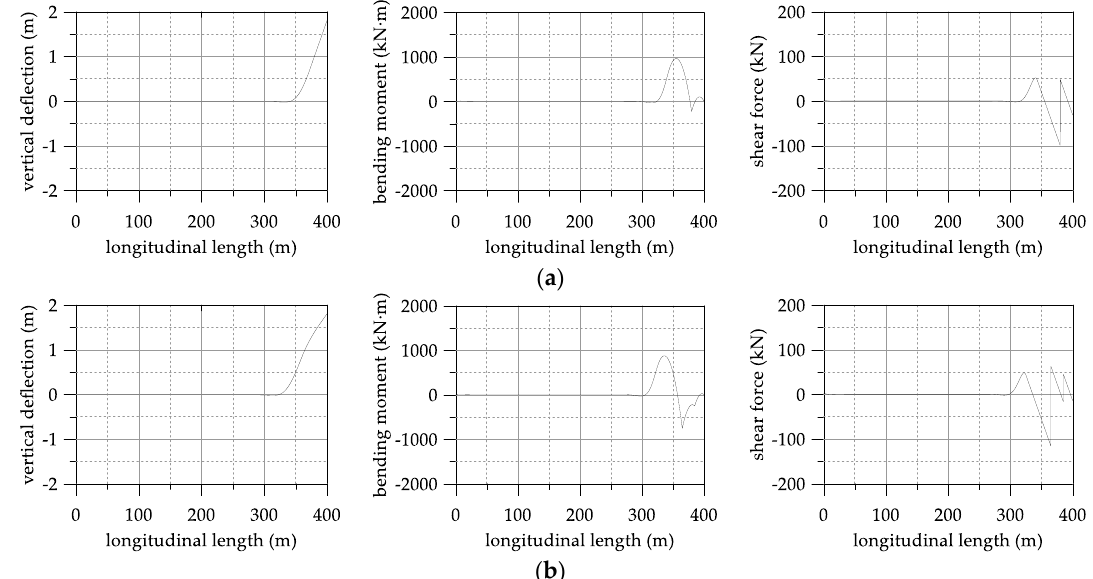
Figure 10. Analysis results of the segmental pipeline model during lowering-in for ( a ) Case 1; ( b ) Case 2.